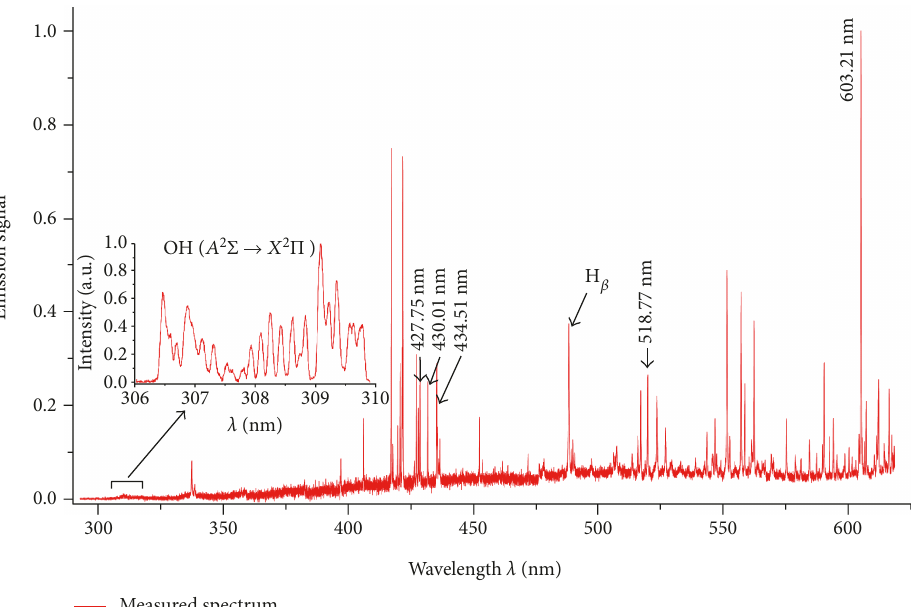
Figure 2: Measured emission spectra of argon plasma (with a small amount of H O vapour) with selected argon 4 p – 4 s and 5 p – 4 s transition 2 lines for Boltzmann plot method. Absorbed microwave power P =3 kW and argon fl ow rate Q =50 l/min. A Table 1: Parameters of selected argon emission lines used to determine the excitation temperature of the electrons T . n / m : exc energy levels upper/lower, respectively; λ : wavelength of nm : Einstein coe ffi cient for transition n → m , transition n → m , A nm : statistical weight of the upper level n . E is the energy of the g n n upper level n .